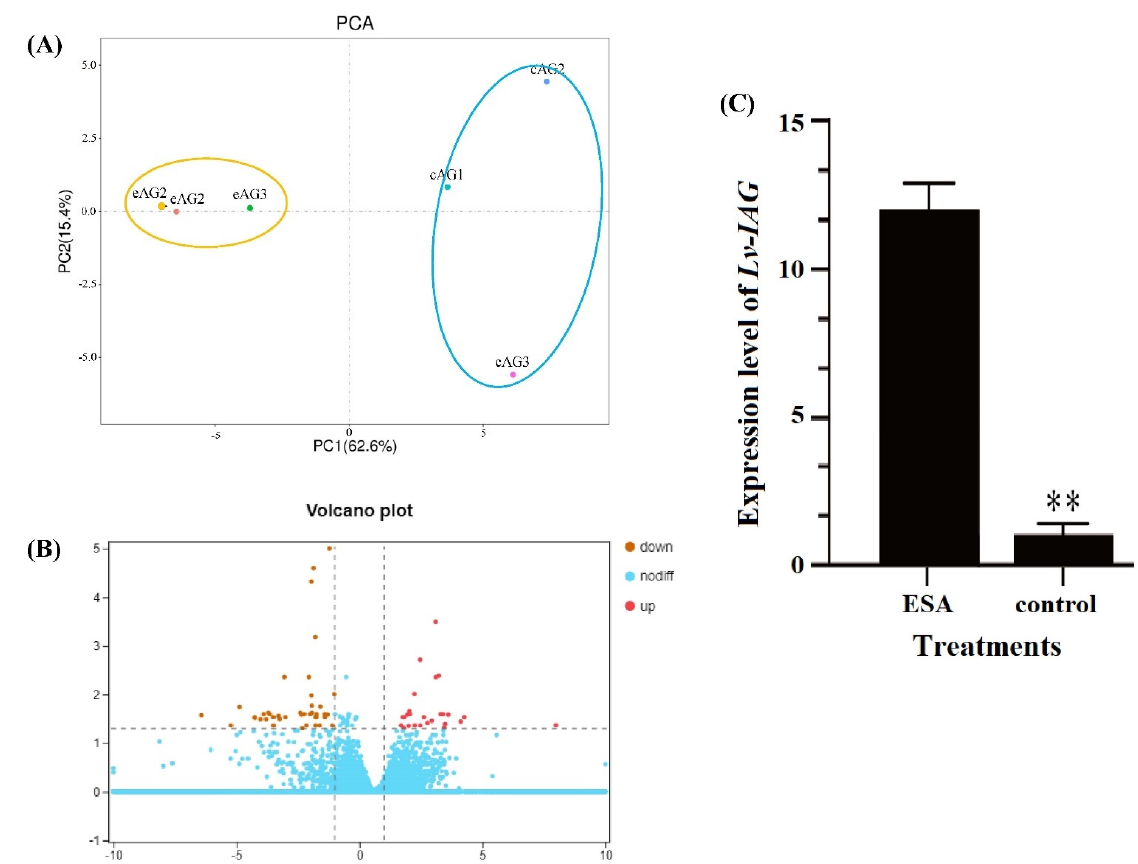
Figure 1. Principal component analysis (PCA) of the transcriptome, identification of differentially expressed genes (DEGs), and confirmation of Lv-IAG expression by RT-qPCR. ( A ) shows the PCA result of the ESA group (eAG1, eAG2, and eAG3) and the control group (cAG1, cAG2, and cAG3). The first two axes account for 15.4% (PC1) and 62.6% (PC2) of the variation. ( B ) shows the expression volcano plot of DEGs between the unilateral eyestalk ablation group and the control group. The abscissa represents the logarithm of the expression fold change of DEGs relative to control. The ordinate represents the negative logarithm of the statistical significance of the expression difference. The red dots represent up- regulated DEGs, the yellow dots represent down-regulated DEGs, and the blue dots represent non-DEGs. ( C ) shows the Lv-IAG expression profiles validated by RT-qPCR. Data are represented as means of fold change and standard deviations (n = 3). Statistical difference was determined using Student’s t -test (** p < 0.01).